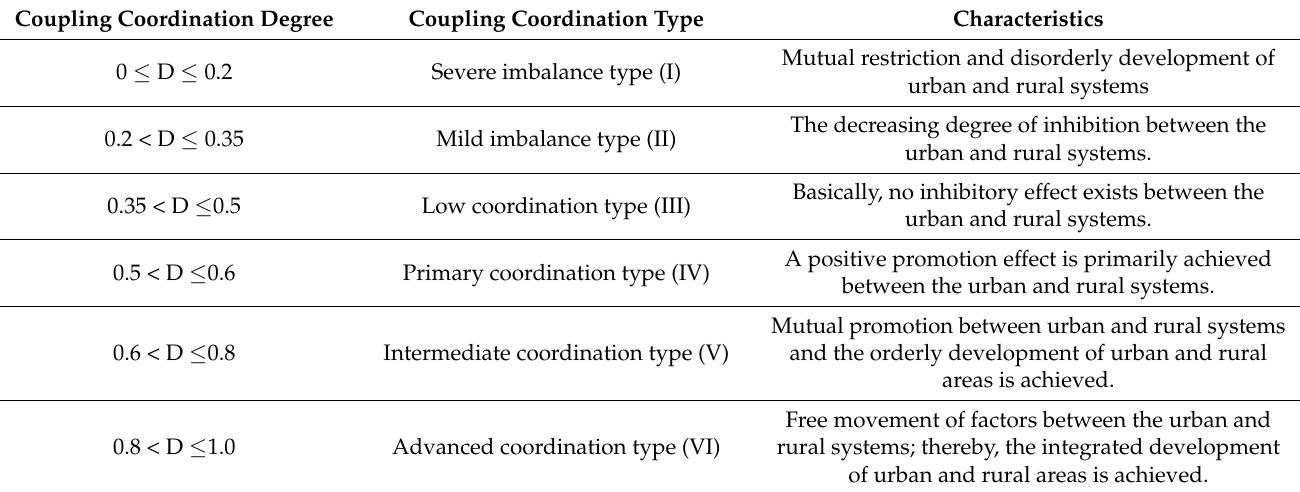
Table 2. The Coupling Coordination State Division Standards for the Urban–rural Integration System in Northeast